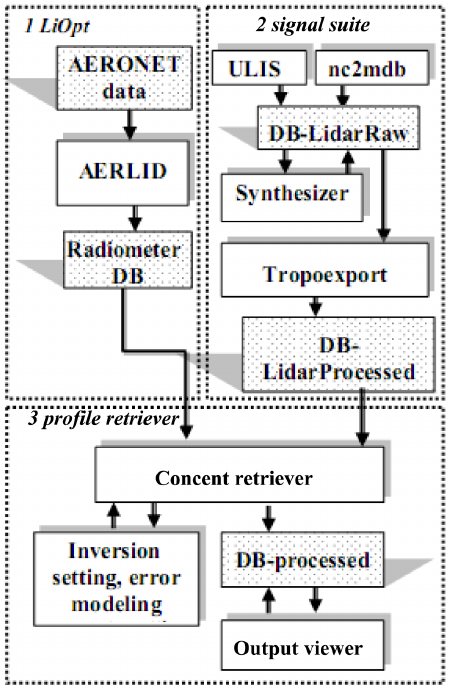
Figure 2. Flowchart of the program